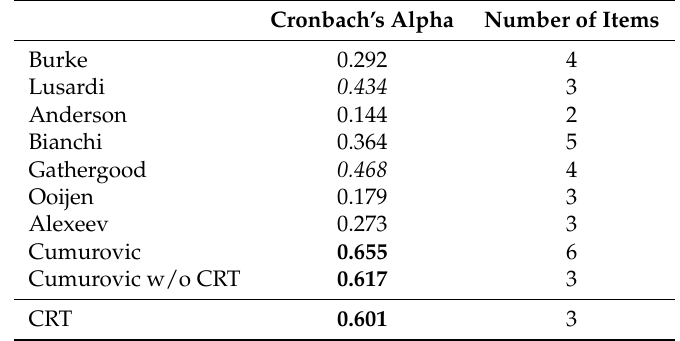
Table 4. Reliability of financial literacy measurements and cognitive reflection (CRT). Values